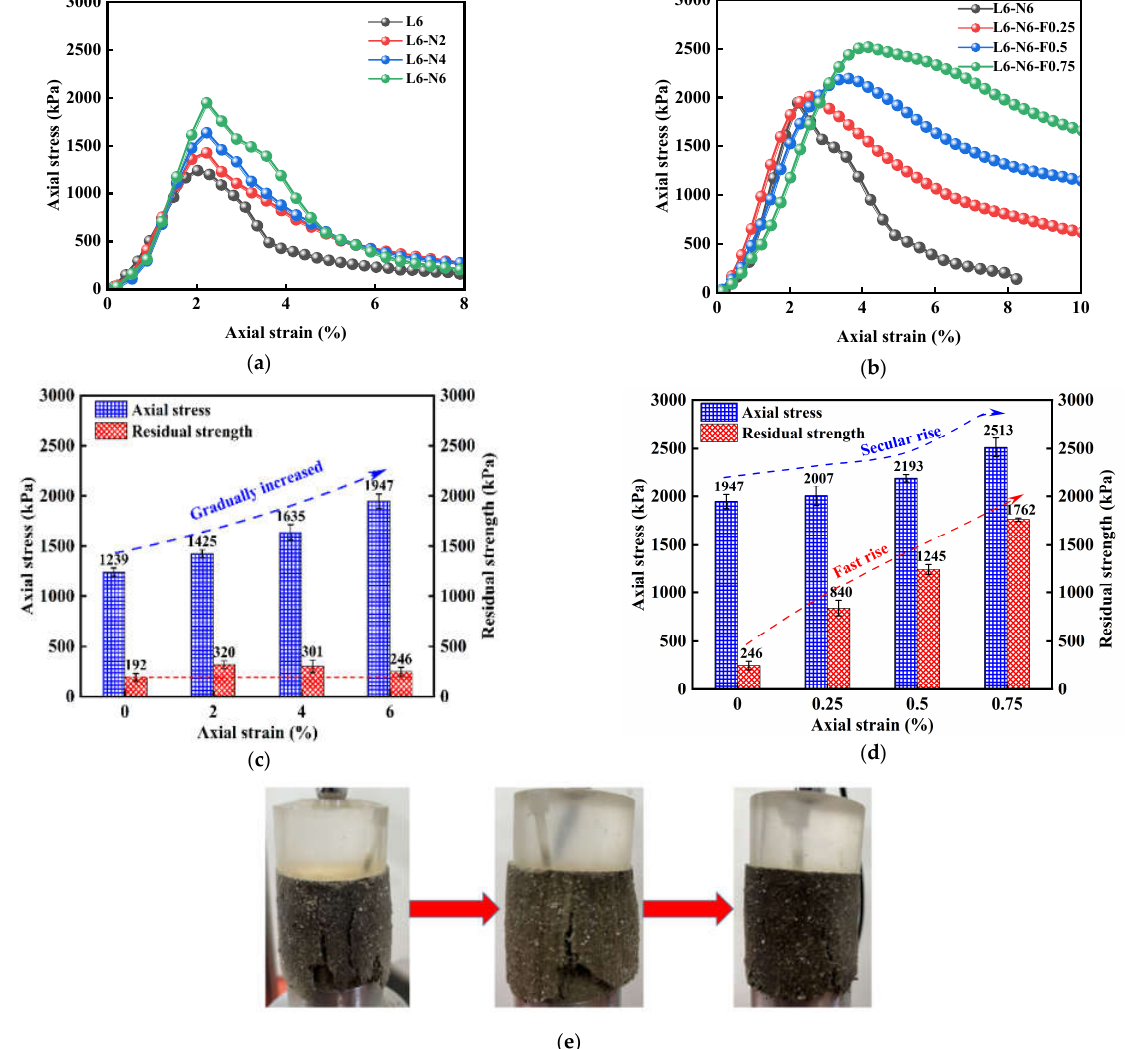
Figure 4. Effect of PF on the statics of NFLS: ( a ) stress–strain curve of NLS; ( b ) stress–strain curve of NFLS (N = 6%); ( c ) UCS and residual strength of NLS; ( d ) UCS and residual strength of NFLS (N = 6%); and ( e ) the variation of cracks with the content of polypropylene fiber under the same strain.